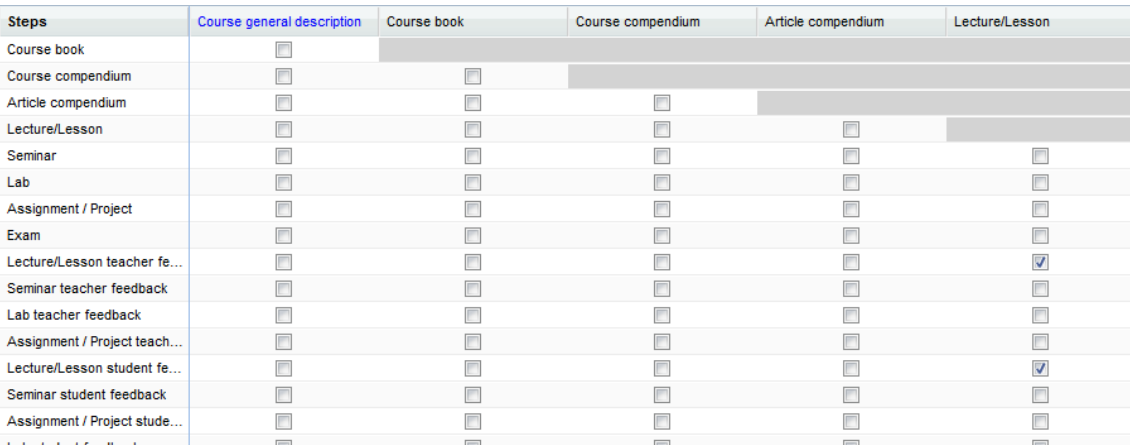
Figure A7. Synchronization